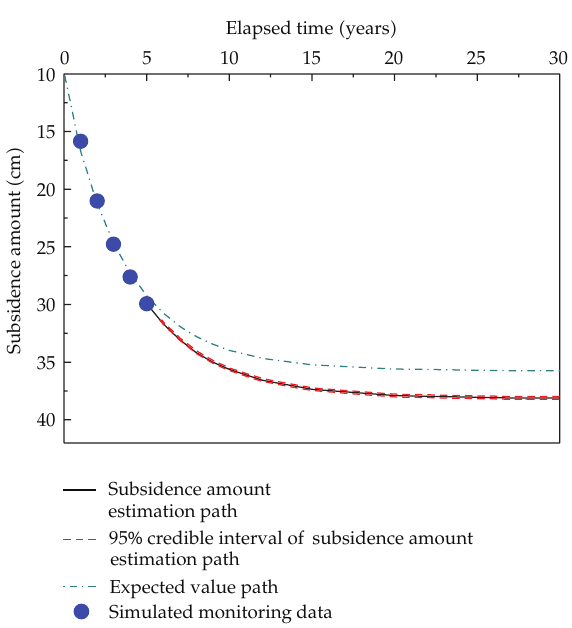
Figure 8: Subsidence estimation results at 5th year.